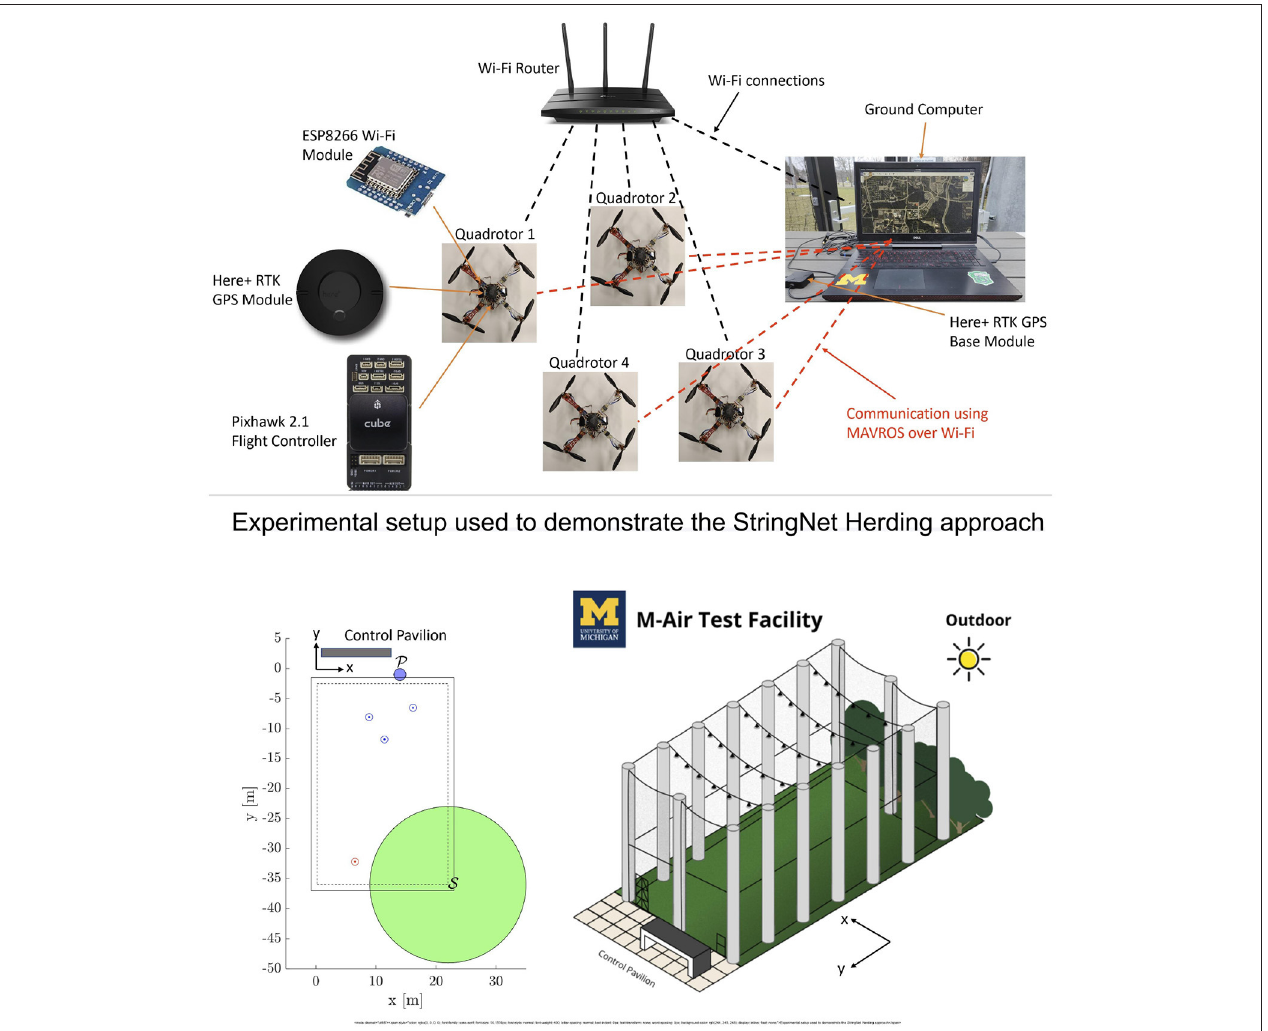
FIGURE 13 | Experimental setup, M-Air facility and the initial configuration (The dotted line in the figure on the left shows the safe region of operation inside M-Air